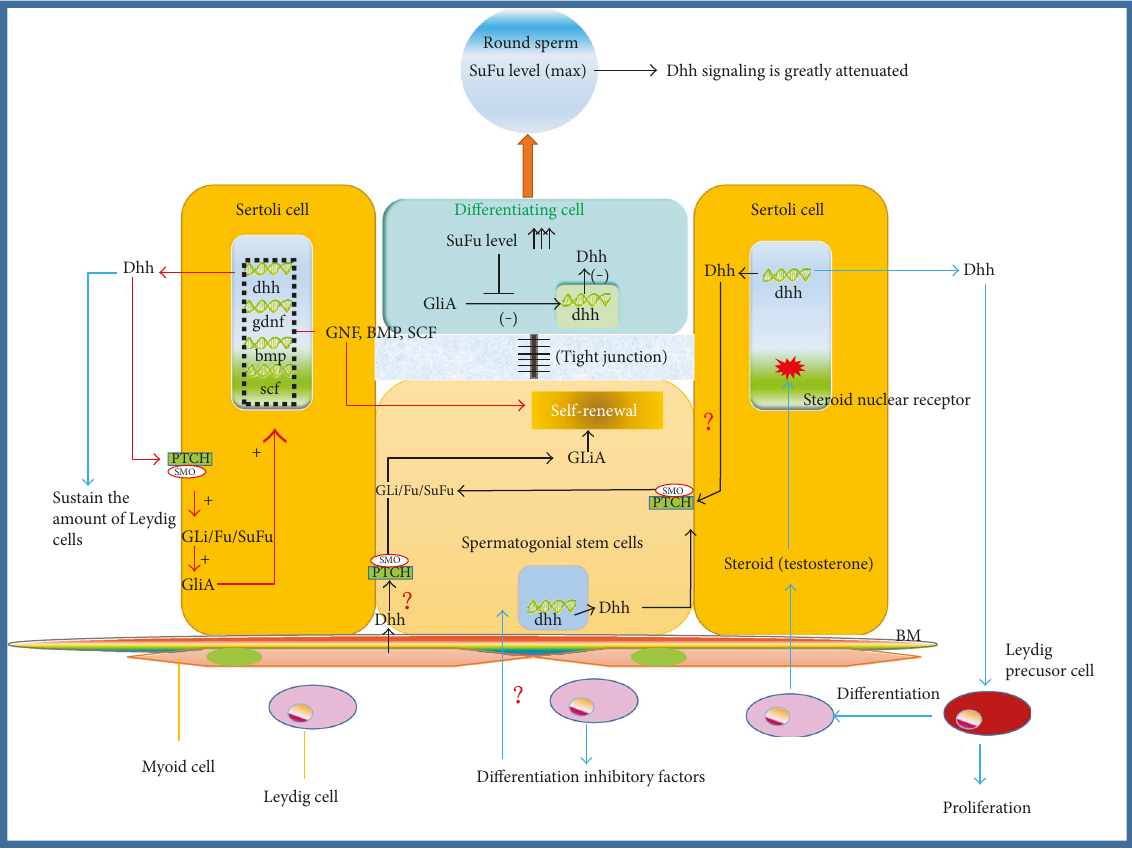
Figure 1: E ff ect of the Hh signaling pathway on the regulation of proliferation and di ff erentiation of SSCs in mammals. (Arrowhead in red in this fi gure) Hh secreted by SCs can promote the expression of various factors in SCs, which helps to maintain SSC proliferation. (Arrowhead in blue in this fi gure) Dhh produced by SC is crucial for LCs for maintaining the number of LCs and expression of testosterone, which is favorable for the di ff erentiation of SSCs. LCs also produce some unde fi ned inhibitory factors that inhibit SSC di ff erentiation. (Arrowhead in black in this fi gure) as SSCs di ff erentiate, the expression of SuFu (a negative regulator of the Hh pathway) constantly increases. It inhibits the activity of the Hh pathway, which is bene fi cial for the di ff erentiation of SSCs (arrowhead in black in this fi